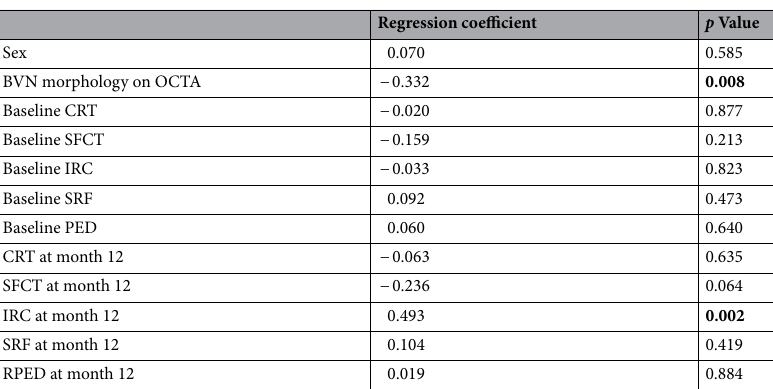
Table 3. Linear regression analysis for prognostic factors correlated to the final visual prognosis after the first episode of PDT at 12 months post-treatment. PDT photodynamic therapy, BVN branching vascular network, OCTA optical coherence tomography angiography, CRT central retinal thickness, SFCT subfoveal choroidal thickness, IRC intraretinal cyst, SRF subretinal fluid, RPED retinal pigment epithelial detachment. Bold values indicate p < 0.05 and were considered statistically